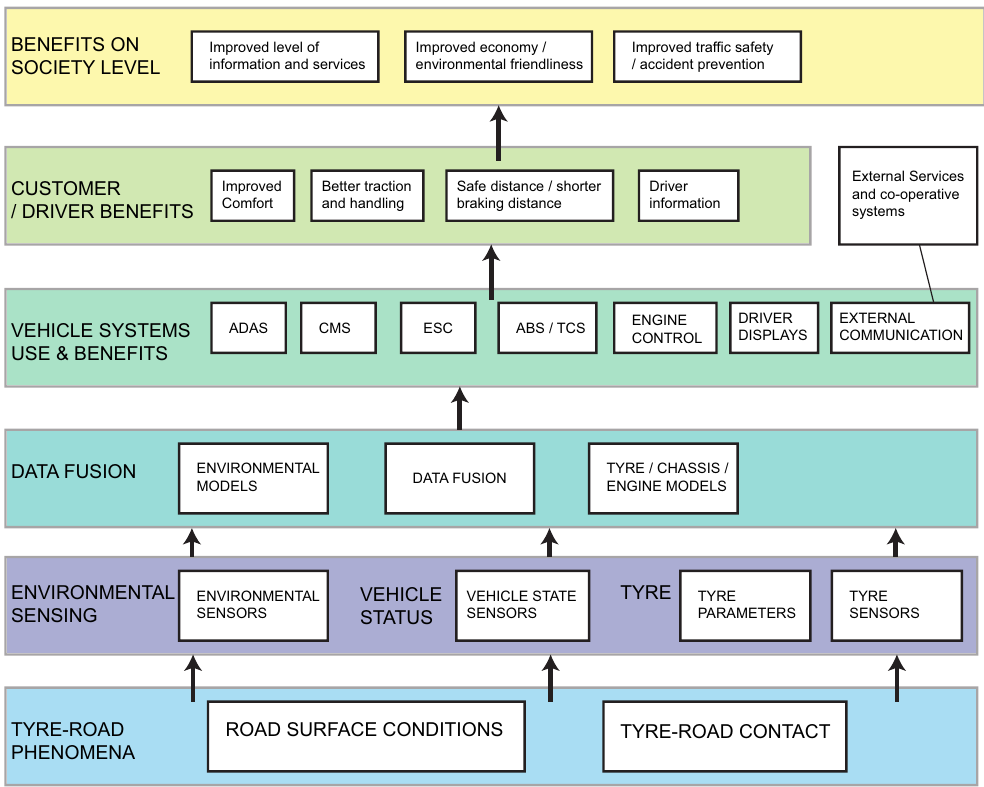
Figure 8. Benefit of the collection and distribution of the friction information on several applications. Diagram adapted by the authors from Koskinen